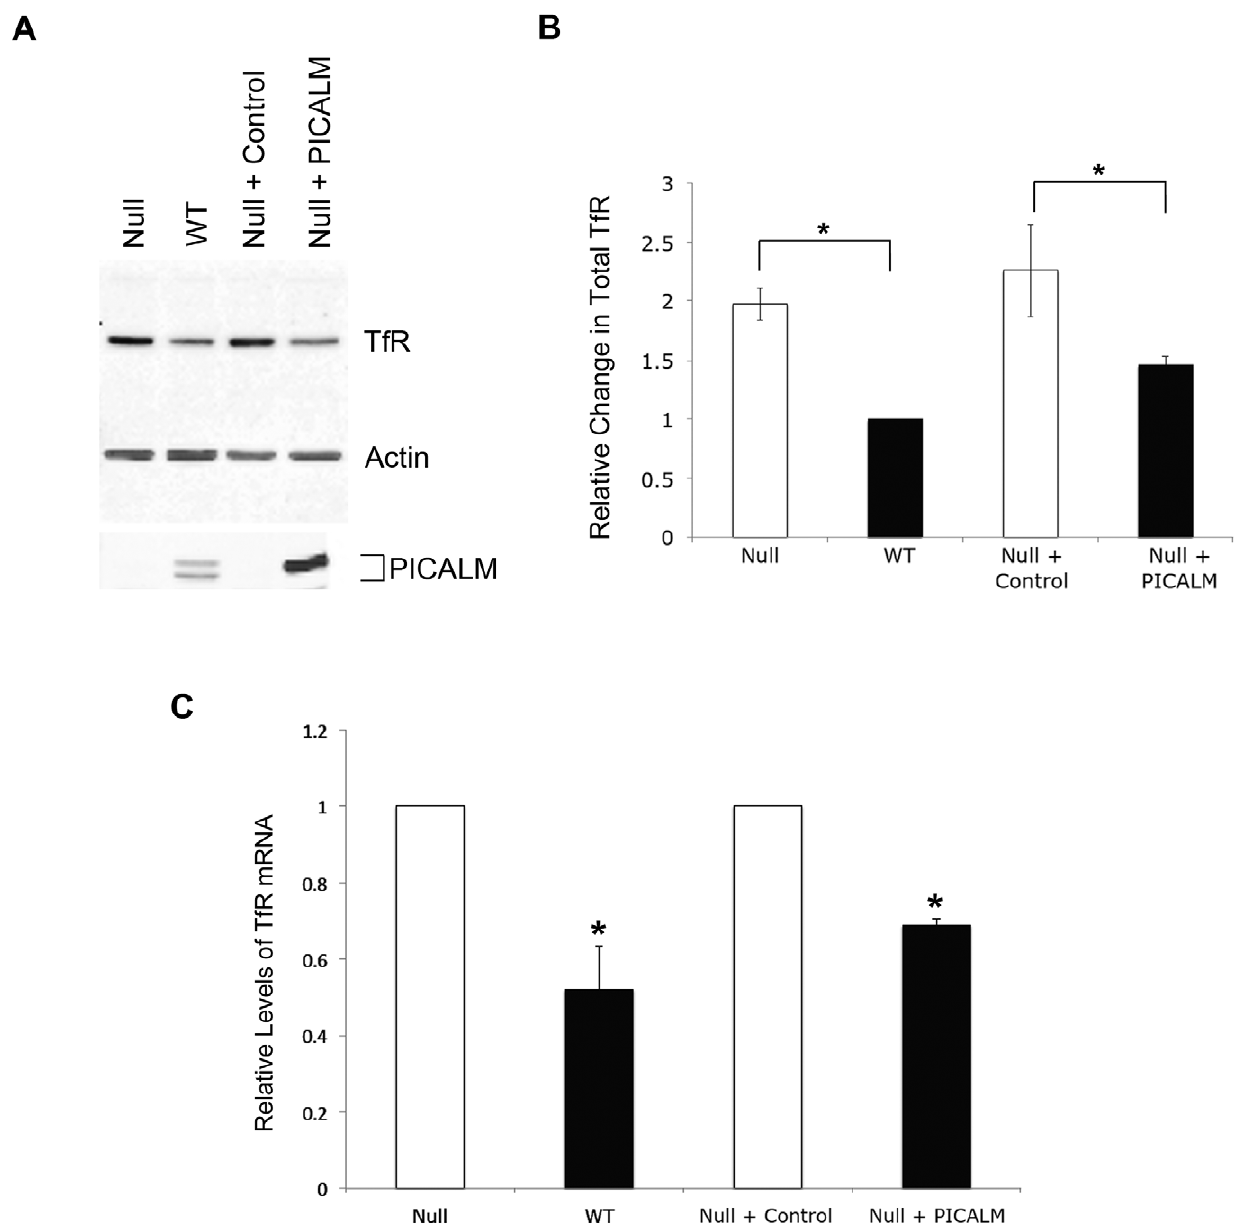
Figure 3. PICALM-deficient cells display increased total TfR protein and mRNA. ( A ) Immunoblot of total TfR protein, PICALM, and b -actin from Picalm NULL (Null), WT, Picalm NULL control MEFs infected with empty vector (Null + control), or Picalm NULL MEFs rescued with PICALM (Null + PICALM). PICALM cDNA encodes for the larger isoform. ( B ) Quantitation of TfR shown in panel A immunoblot normalized to b -actin, with values shown relative to TfR level in WT MEFs. N exp =3. *p , 0.04. ( C ) RT-PCR quantitation of TfR mRNA in PICALM-deficient (Null) MEFs, WT MEFs, Picalm NULL MEFs transduced with empty vector (Null + Control) or rescued with PICALM (Null + PICALM). Results are normalized to levels in Null MEFs or Null + Control cells. N exp =3. *p , 0.04 compared with WT cells.